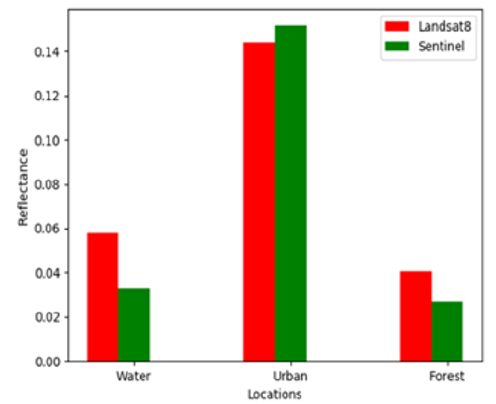
Figure 12. Landsat 8 and Sentinel-2 data corrected with iCOR values for Land